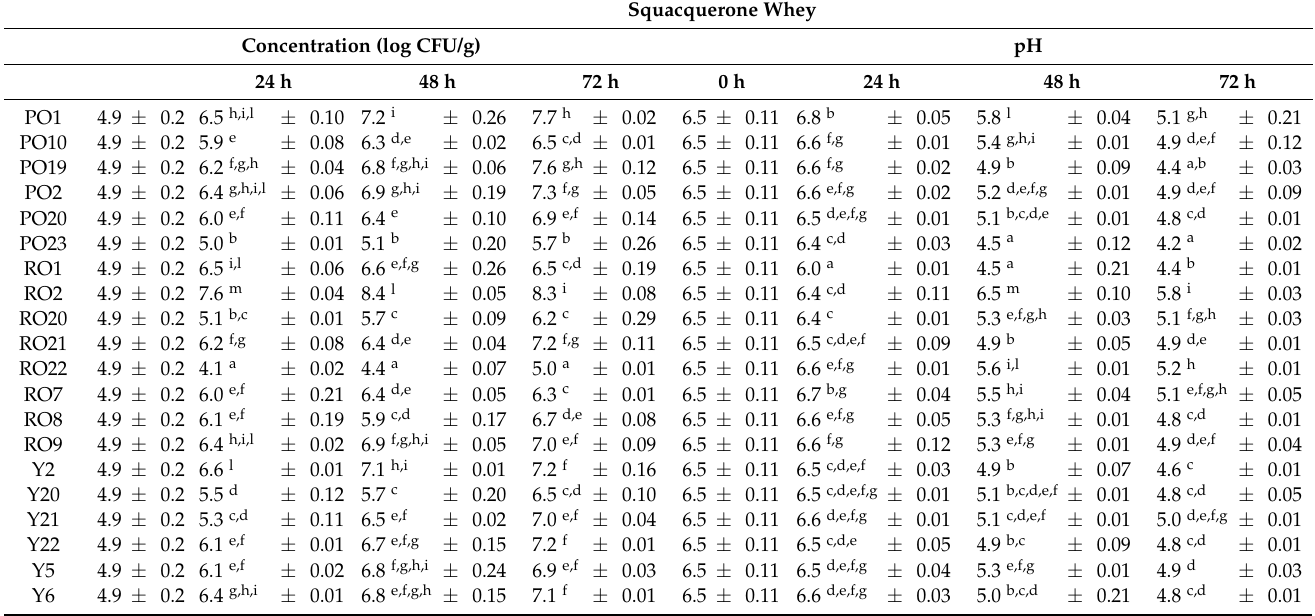
Table 4. Concentrations of Y. lipolytica in squacquerone whey and pH over time. Results are the mean of three different measurements. Different letters mean significant differences ( p < 0.05) within a